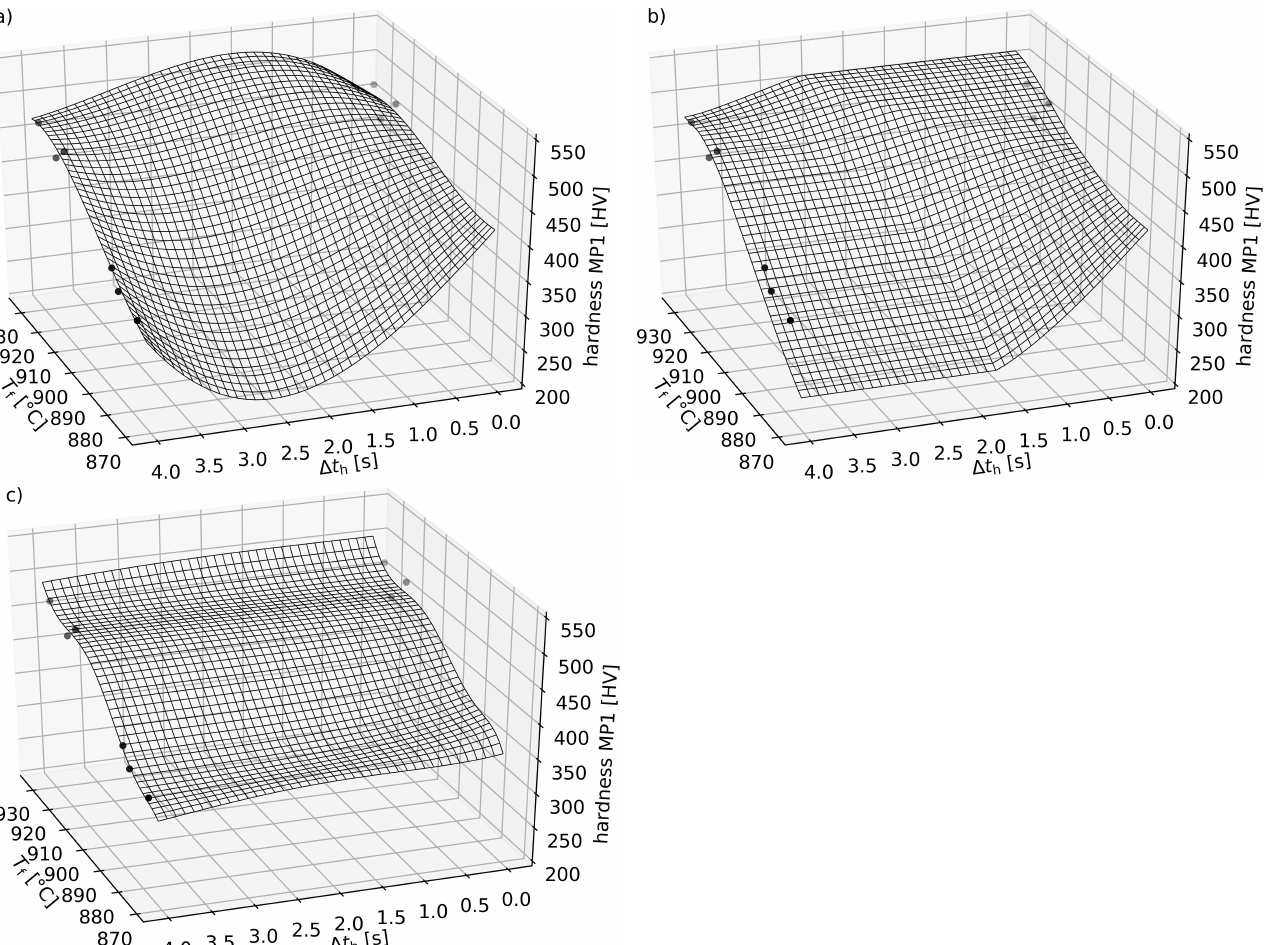
Figure 6. 4D regression for forming and press hardening of sheet metal using polynomial models ( F p = 2250kN, t q = 2s). The markers represent those training points matching the specification of the corresponding plane in the input